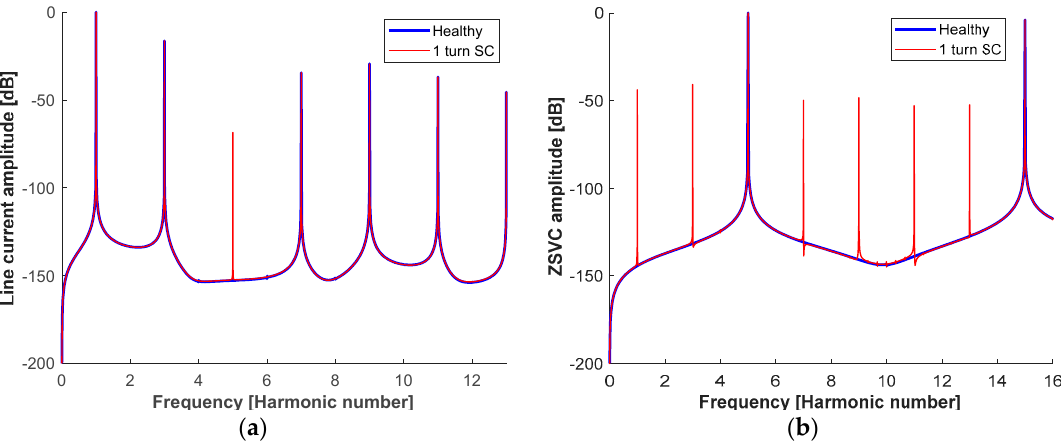
Figure 6. Harmonic frequencies of the fPMa-SynRM operating at rated conditions. Comparison between healthy and faulty conditions (one shorted turn). ( a ) Line current harmonics of the faulty phase. ( b ) ZSVC harmonic frequencies.